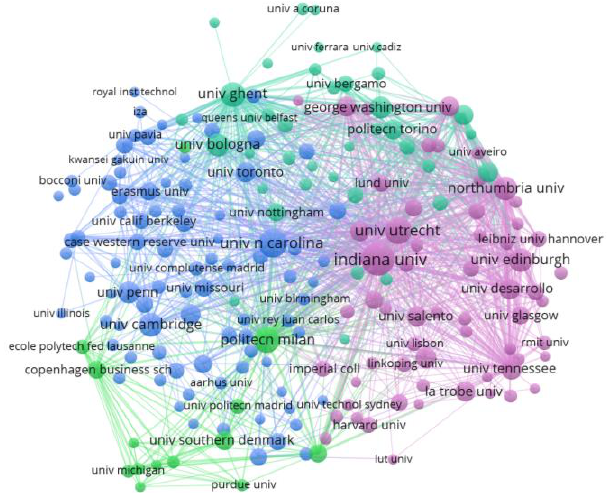
Figure 3. Network visualisation — institutions ’ co-authorships (VOSviewer).